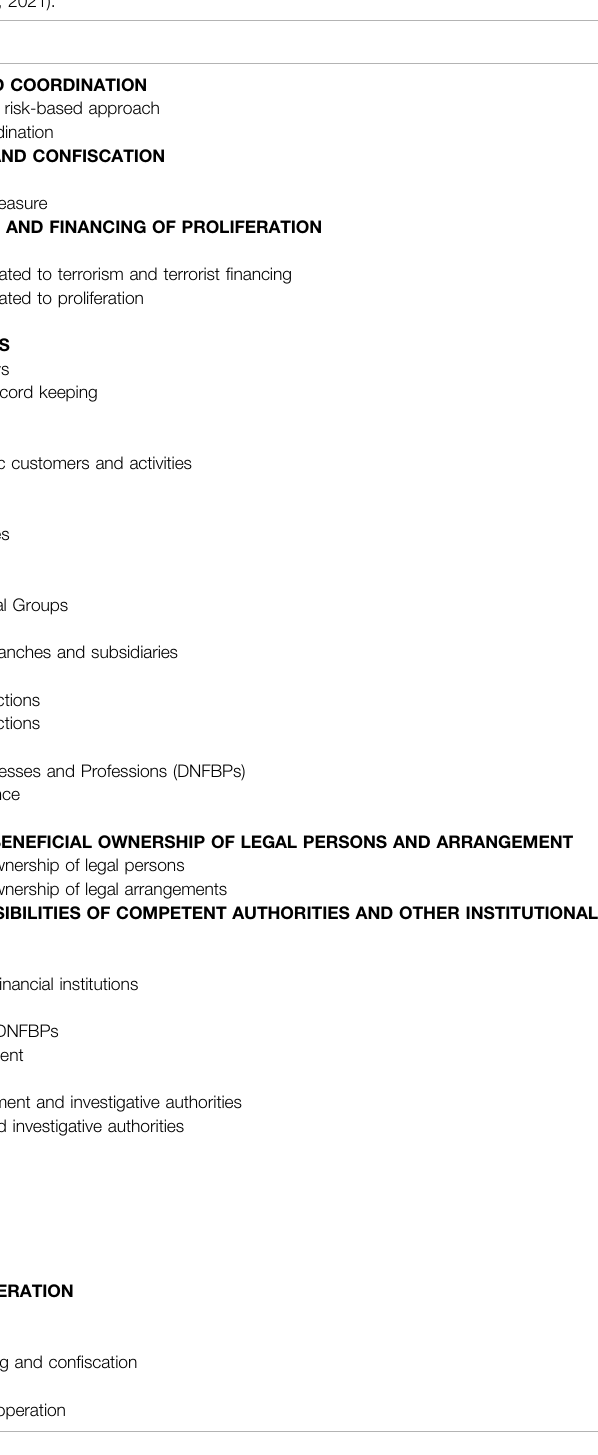
TABLE 2 | Overview of the FATF 40 + 9 Recommendations (as of February 15,